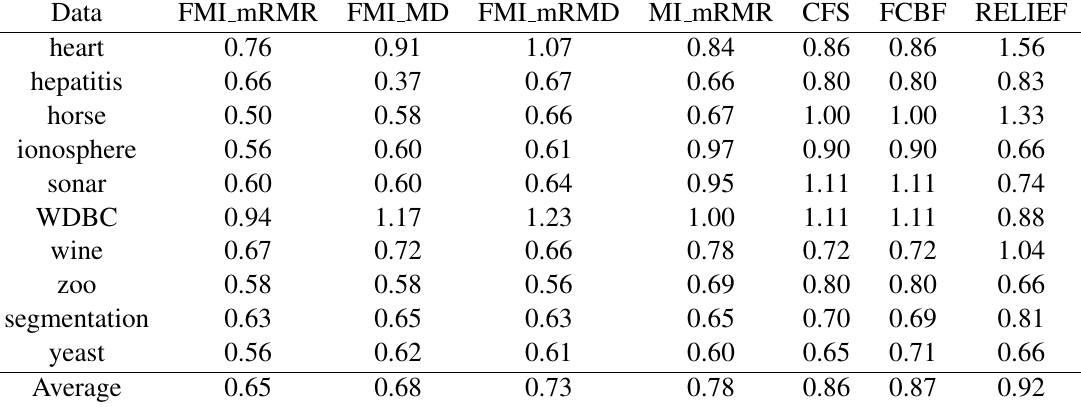
Table 4: Stability of feature